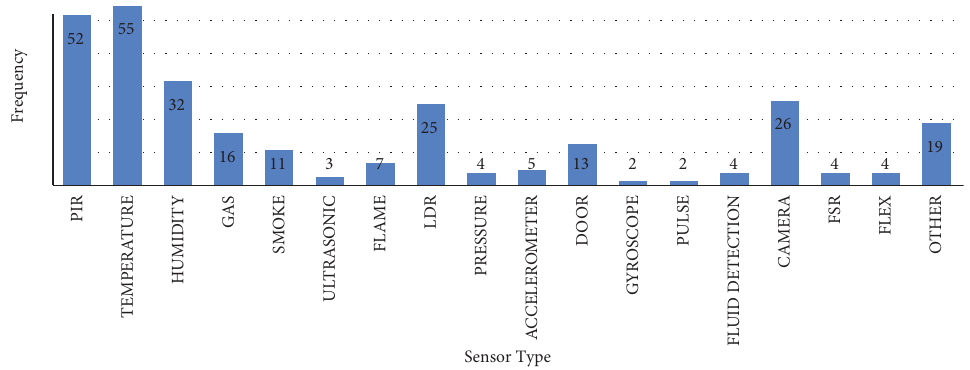
Figure 10: Frequency of diferent sensor usage in